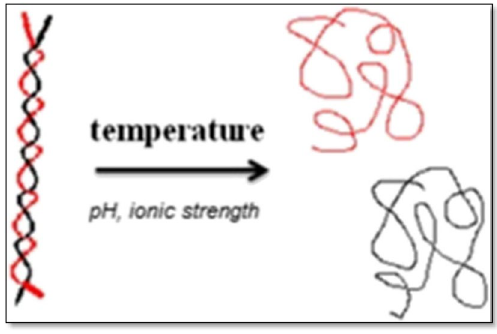
Fig. 9 Conformational transitions of xanthan gum in aqueous solu- tions